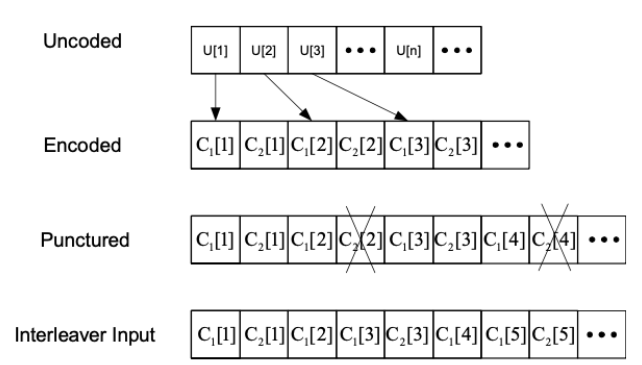
Figure 4. Convolutional code block diagram for CC1 and CC2.